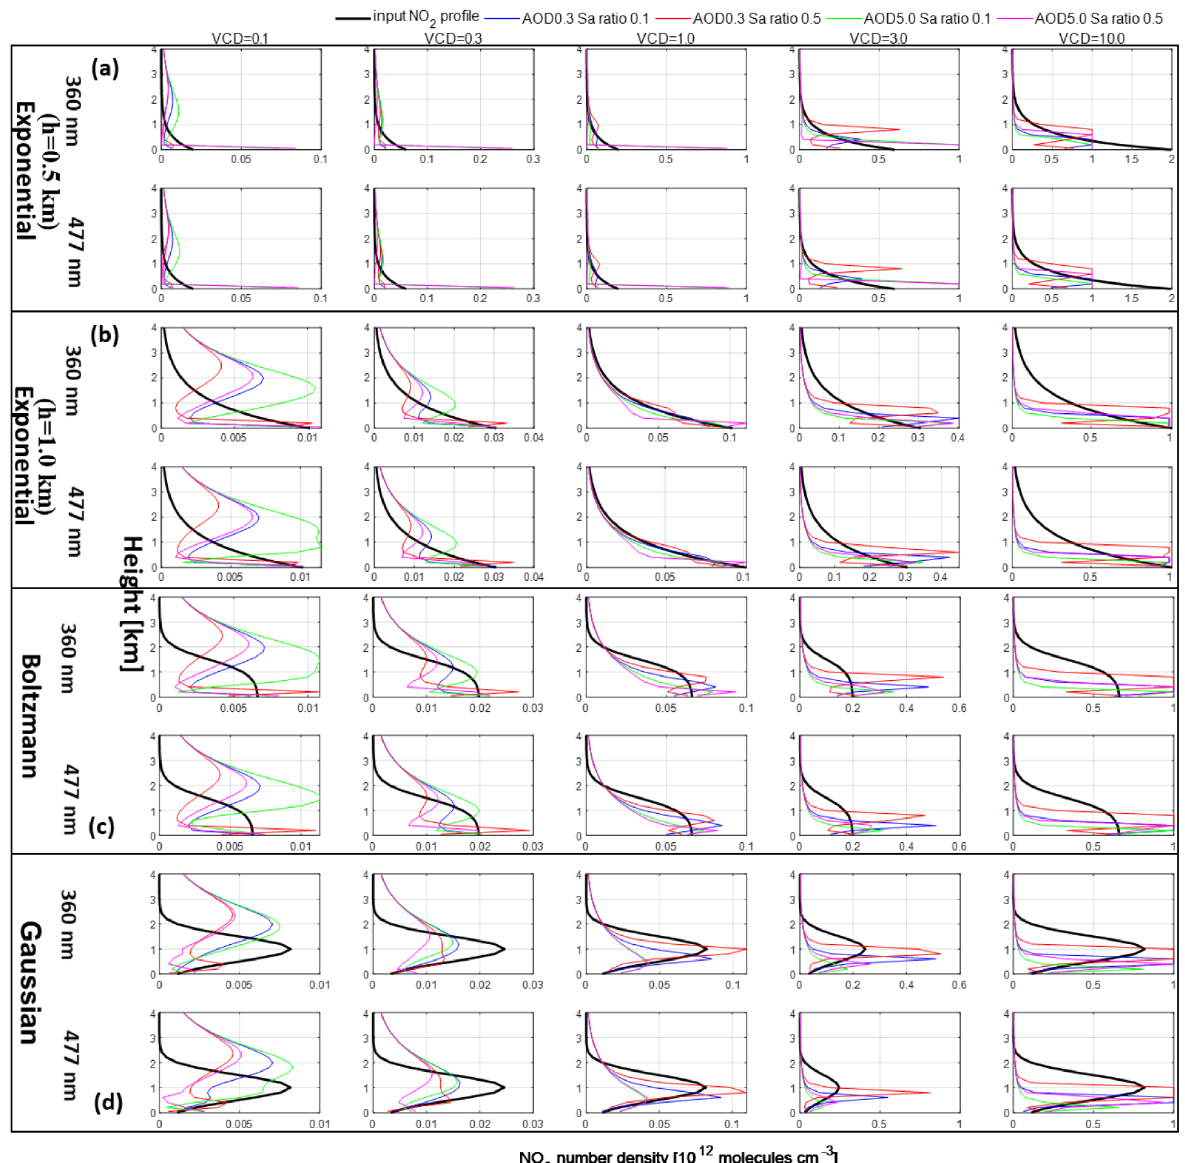
Figure 15. Retrieved NO 2 profiles by PriAM for S a of 0.1 and 0.5 and AOD of 0.3 and 5.0, along with the input NO 2 profiles for (a) expo- nential shape with h = 0.5km, (b) exponential shape with h = 1.0km, (c) Boltzmann shape, and (d) Gaussian shape. The first line in each panel denotes the results for 360nm, and the second line denotes the results for 477nm. The solid and dotted colored lines refer to the AODs and S a shown at the